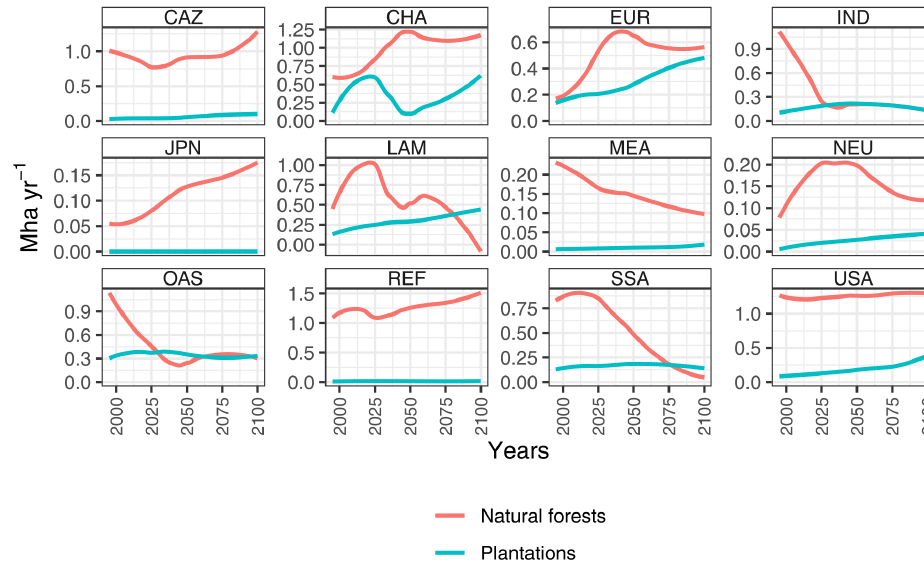
Figure A7. Regional annual area harvested for roundwood production (in Mhayr − 1 ) by source.